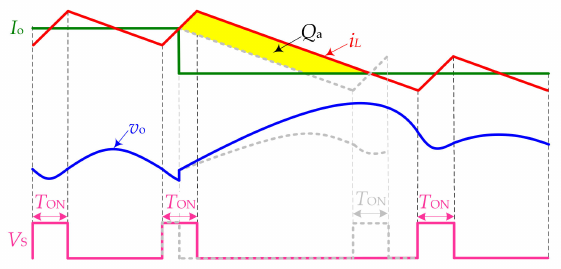
Figure 5. Unloading transient performance limitation for COT controller.